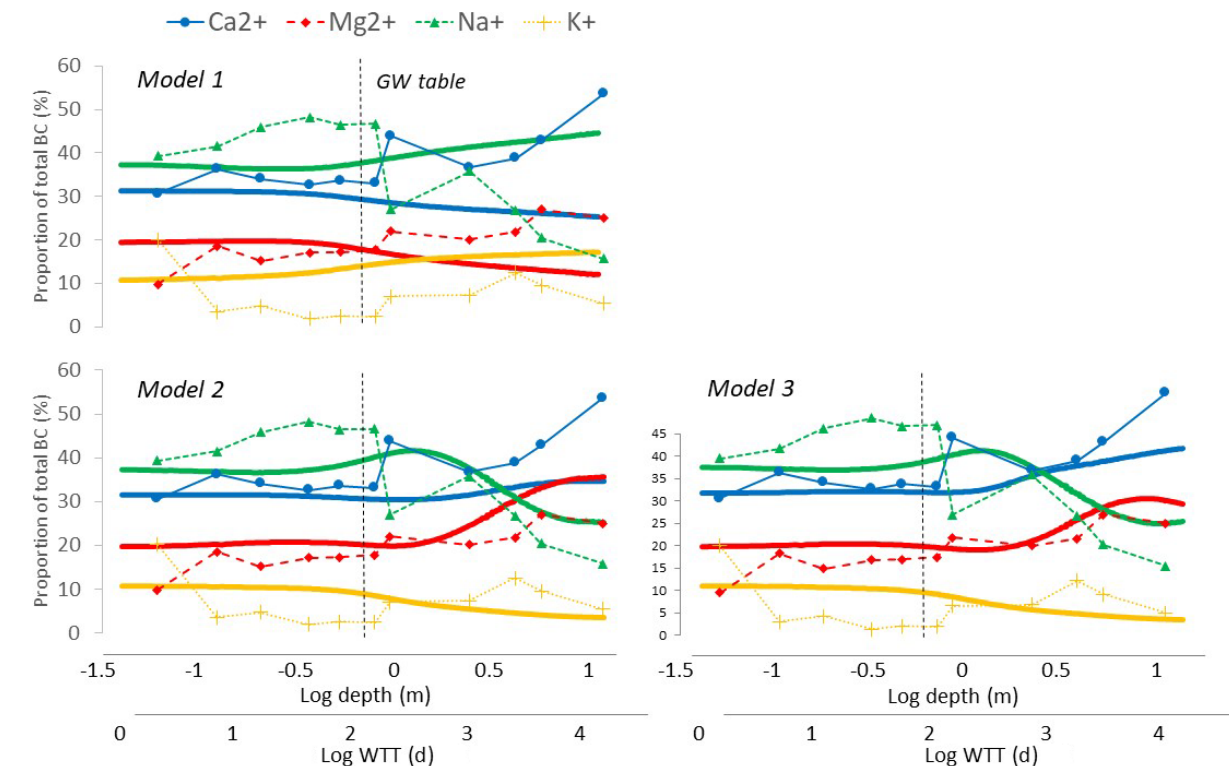
Figure 7. The calculated base cation ratios (Ca 2 + / BC, Mg 2 + / BC, Na + / BC and K + / BC) from the three different models plotted against the log WTT (thick lines). Model 1 uses the original PROFILE equations, model 2 uses the revised PROFILE equations and model 3 uses the revised PROFILE equations with plagioclase split in two phases that dissolve separately. For comparison, the base cation ratios from the S22 soil profile are displayed on the same graphs (markers are connected with dashed lines) and plotted against the logarithmic depth. Note that the WTT scale is not directly comparable, instead the figures are intended to illustrate trends and ranges of base cation